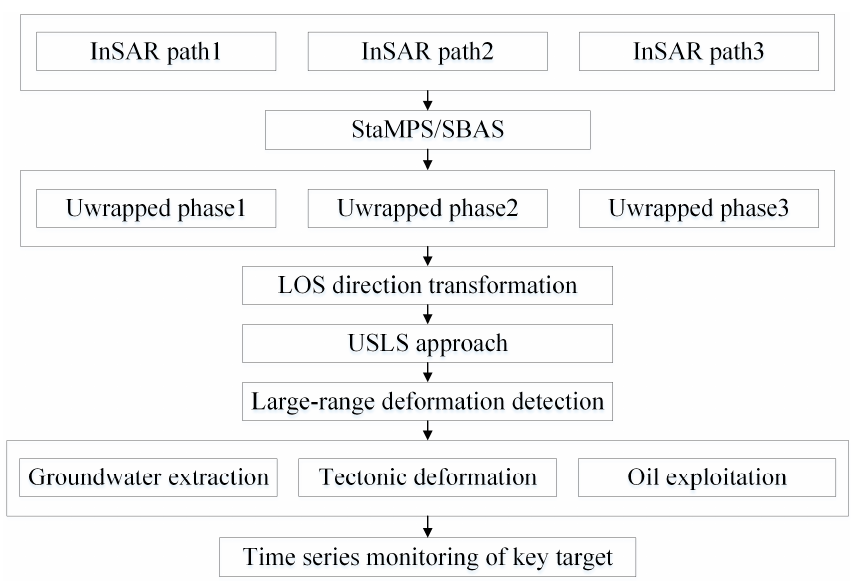
Figure 4. The flow chart of processing.